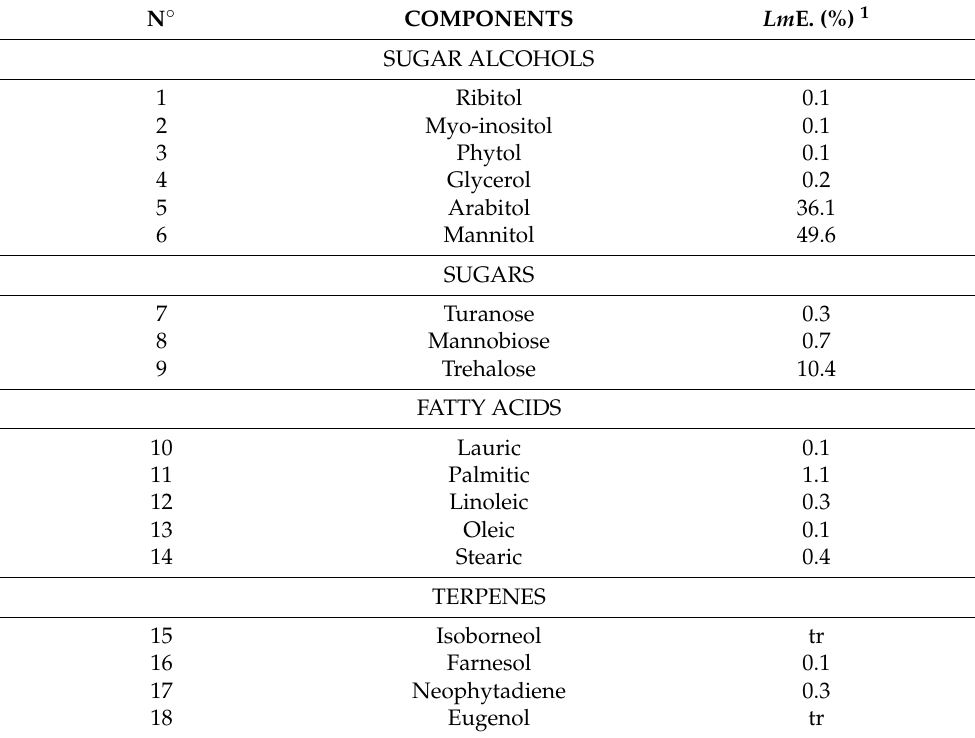
Table 2. Chemical composition (percentage mean values) of L. maritima ethanolic extract after derivatization.